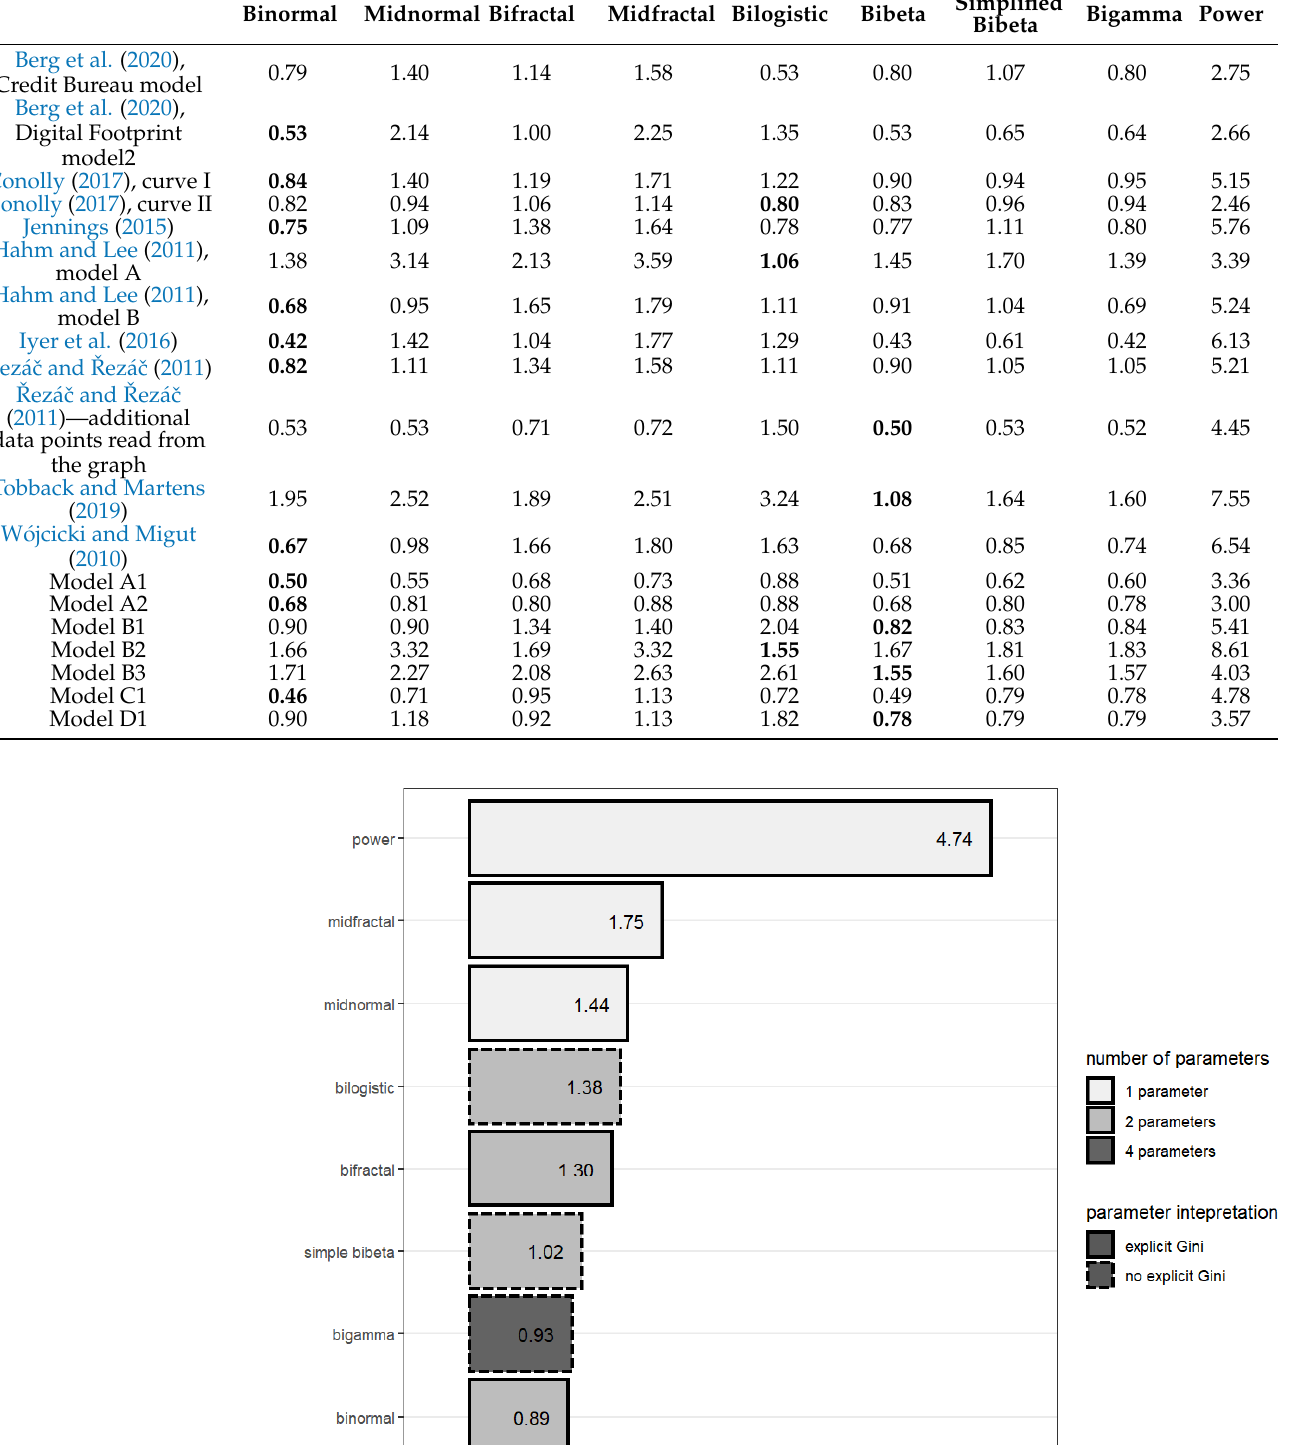
Table 2. ROC model curve fitting—the goodness of fit (